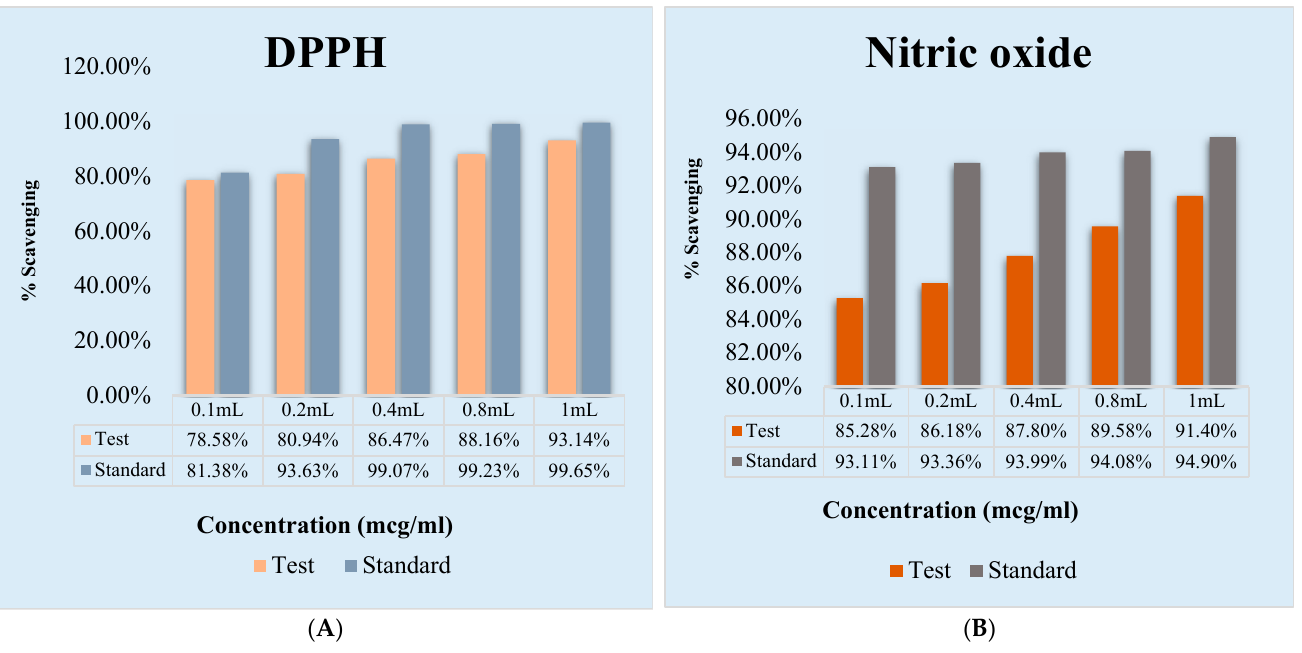
Figure 5. In vitro antioxidant study for optimized gel F10. ( A ) DPPH activity, which shows that it is dose-dependent, ( B ) nitric oxide, the scavenging activity.